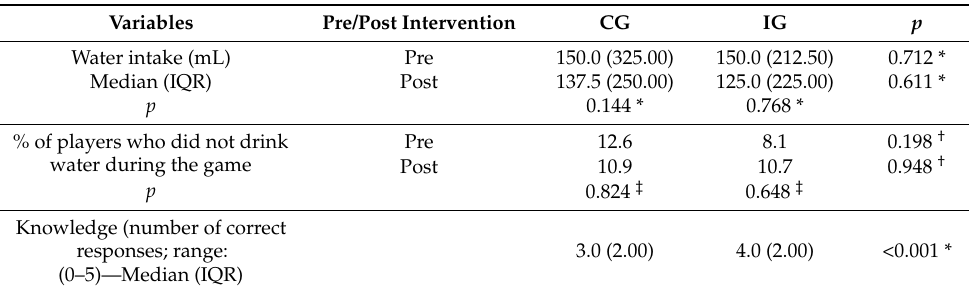
Table 3. Pre- and post-intervention median values for water intake and knowledge for the CG ( n = 128) and the IG ( n = 131), and the differences between the groups. Variables Pre/Post Intervention CG IG p Water intake (mL) Pre 150.0 (325.00)